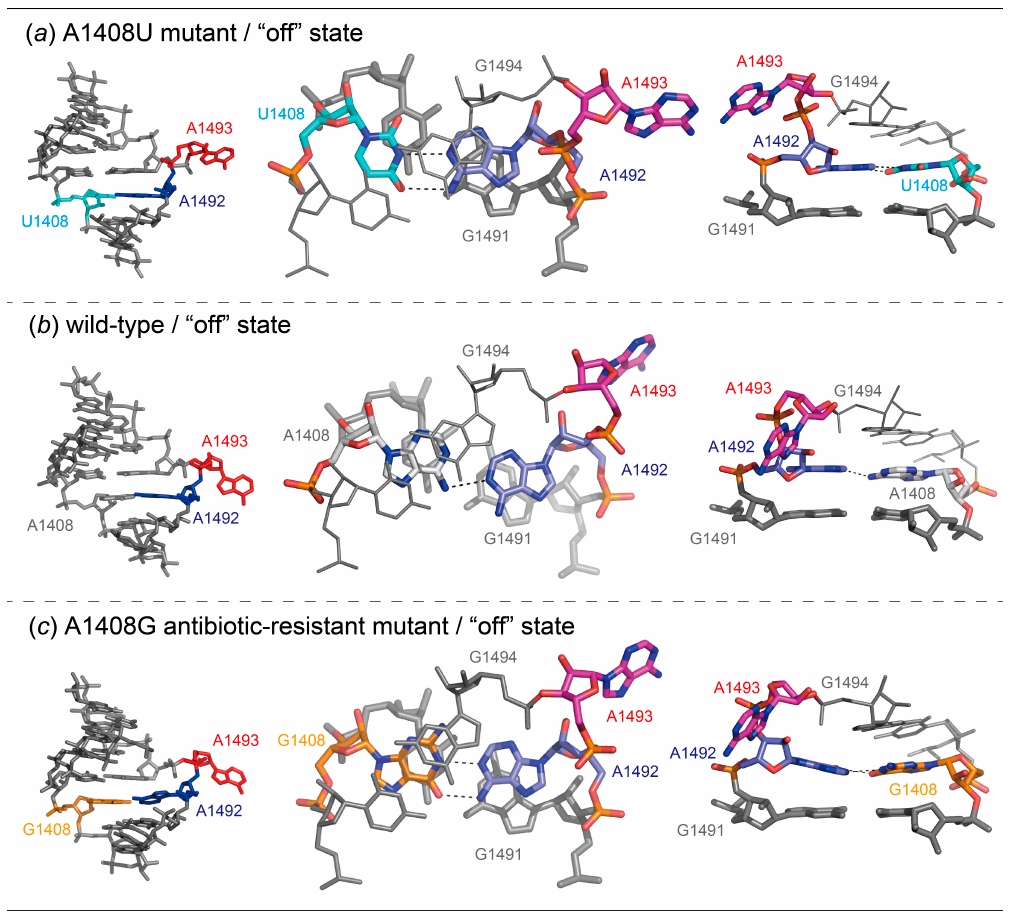
Figure 7. Molecular structures (left) and close-up views of base pairs (center) and stacking interactions (right) observed in the “off” state of the bacterial A1408U lethal mutant ( a ), wild type (24: PDB-ID = 1T0E) ( b ) and the A1408G antibiotic-resistant mutant (29: PDB-ID: 3TD0) ( c ) A sites.